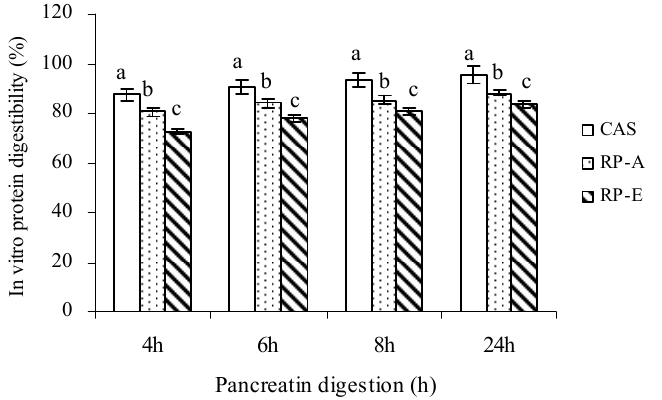
Figure 2. The in vitro digestibility of dietary protein after pepsin (2 h) and pancreatin (4, 6, 8, 24 h) digestion. Values are means ± SEM ( n = 3). Bars for each value with different letters are significantly different ( P <